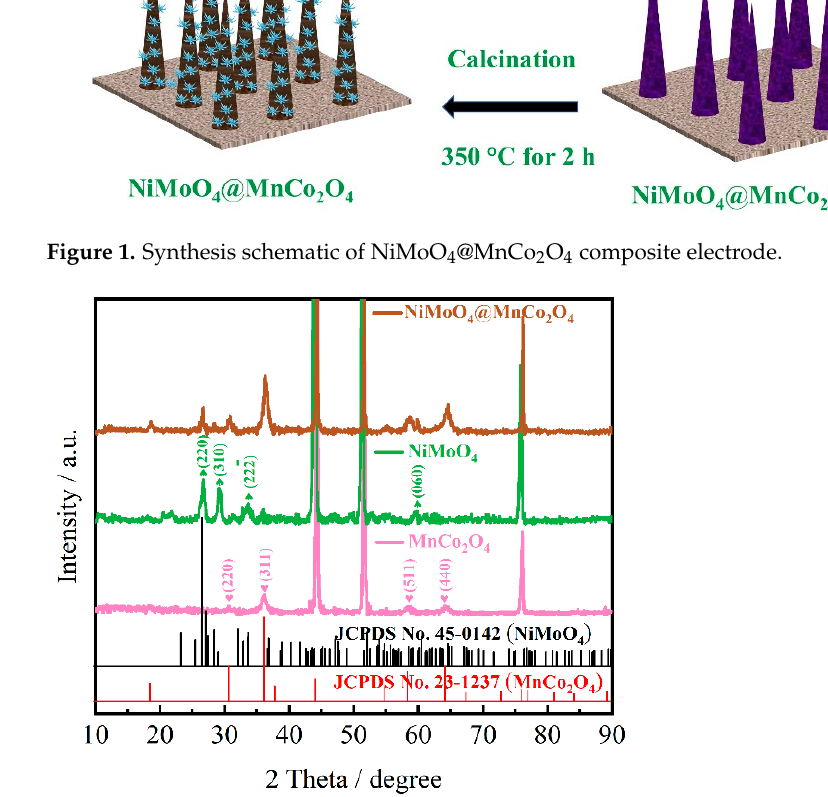
Figure 1. Synthesis schematic of NiMoO 4 @MnCo 2 O 4 composite electrode.